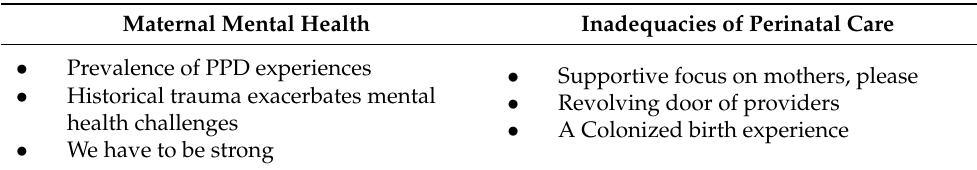
Table 1. Themes and subthemes were identified in story inquiry research of the perinatal experiences of Keetoowah mothers ( N =